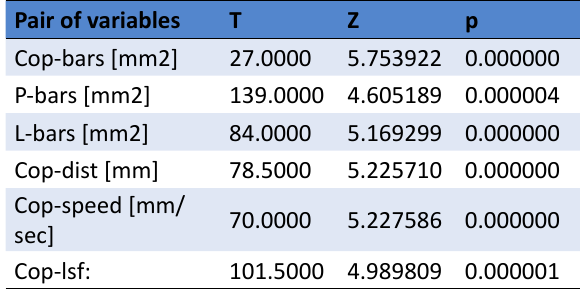
Table 10. Significance of the differences in